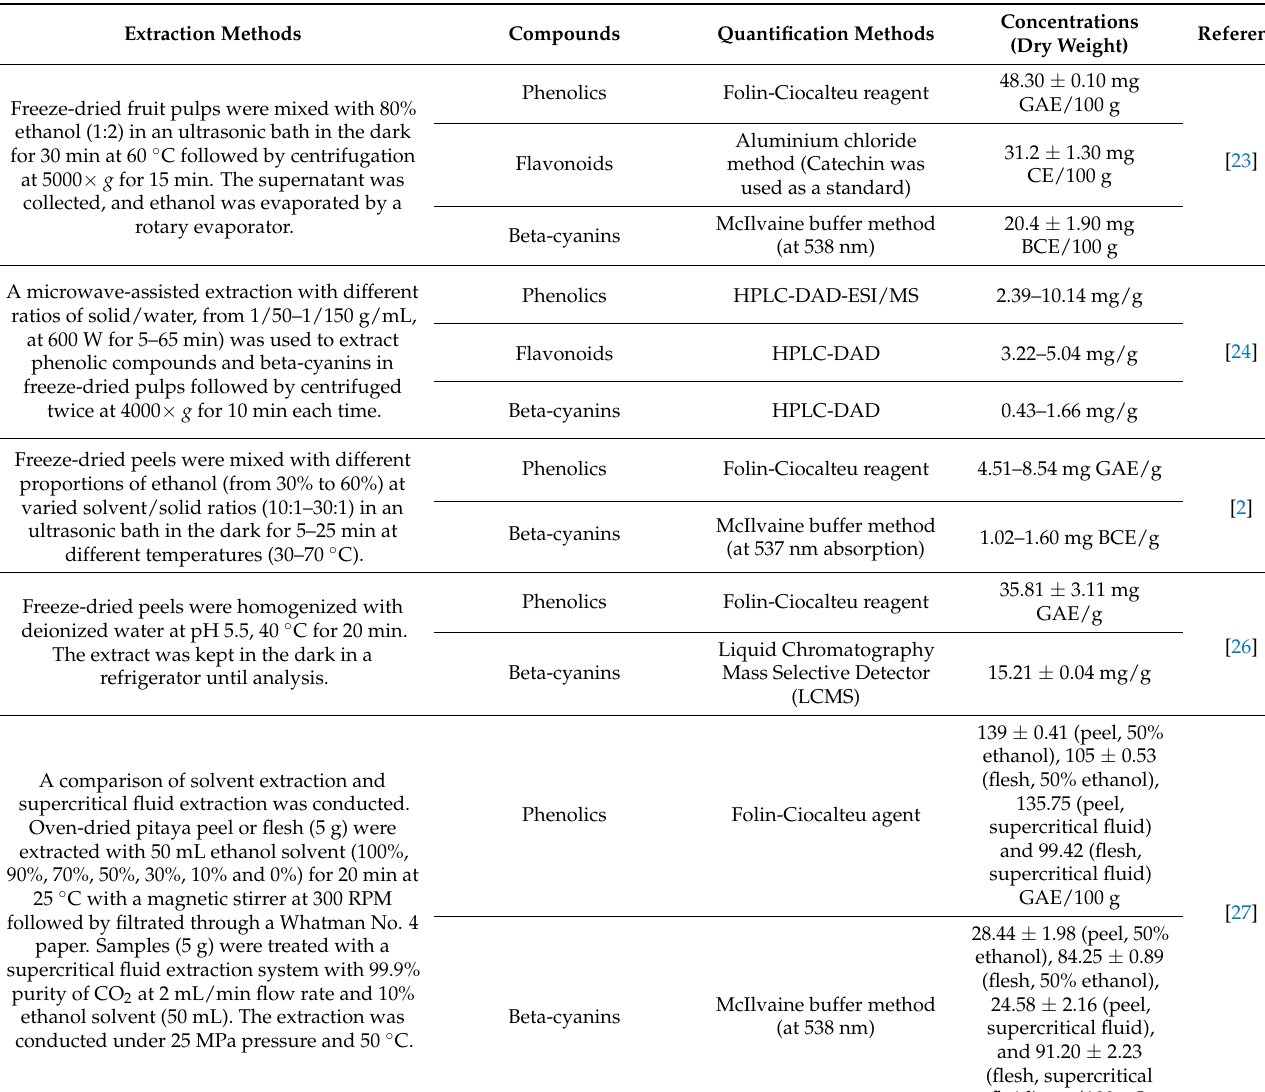
Table 1. Extraction of polyphenols from red